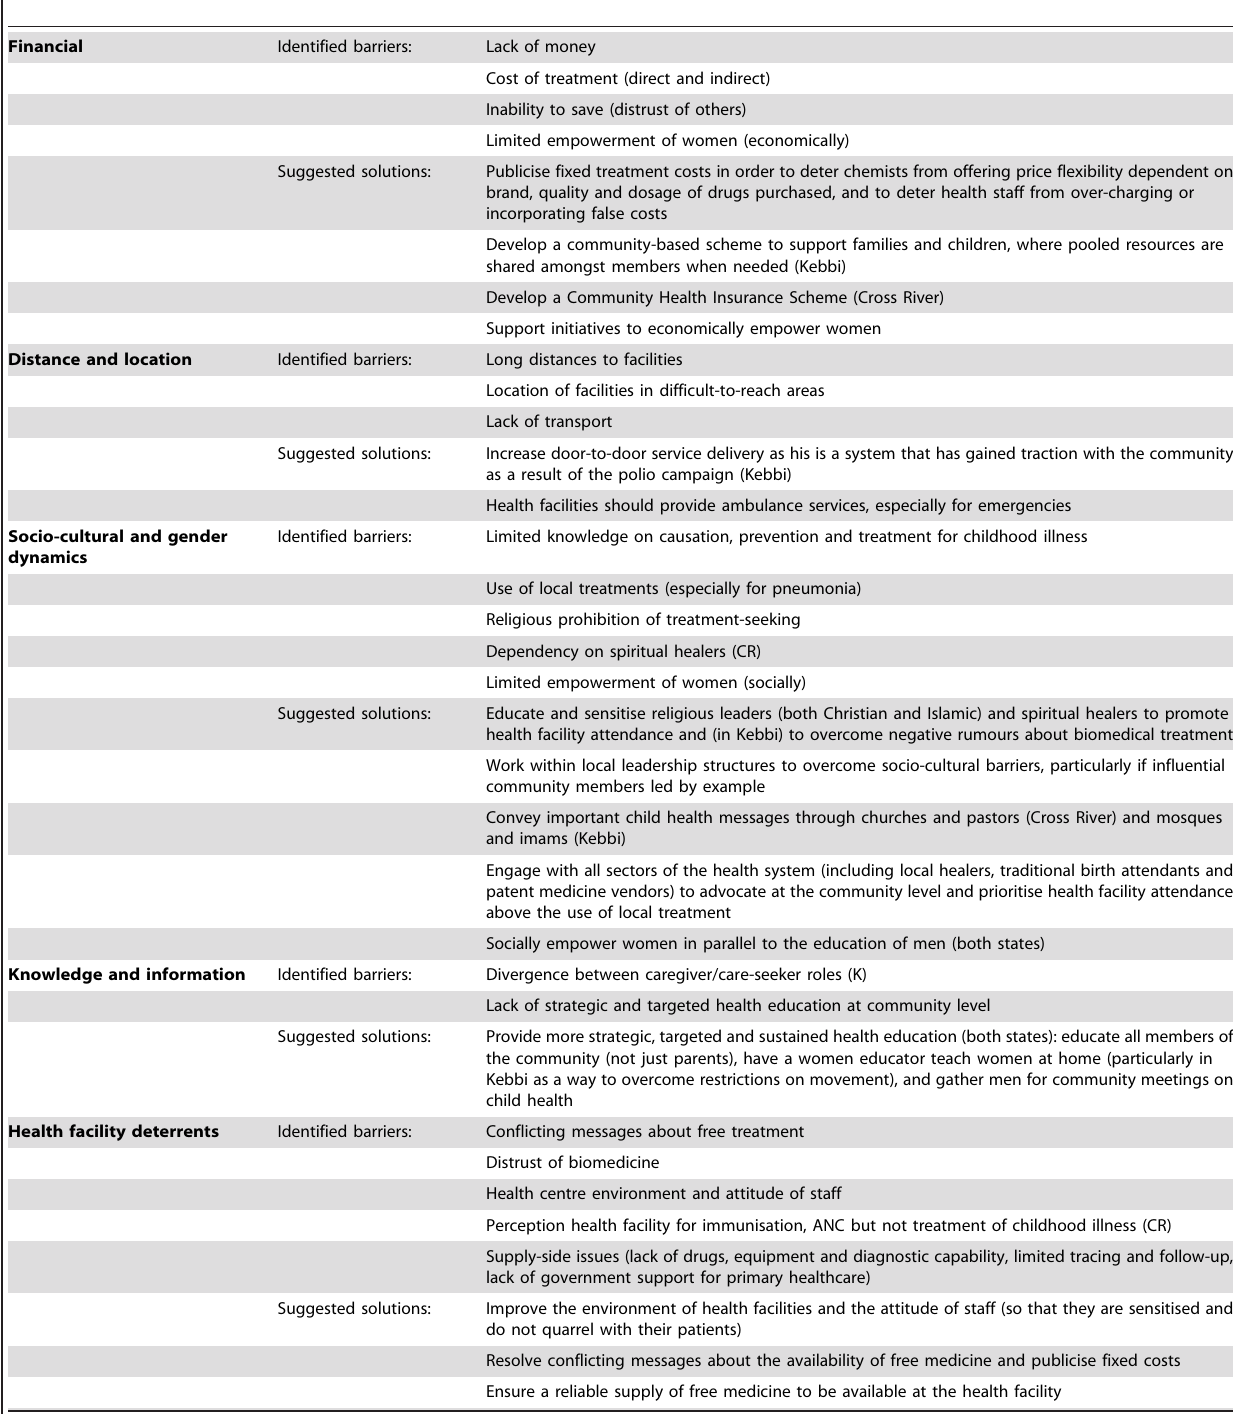
Table 4. Barriers and related solutions identified by caregivers in